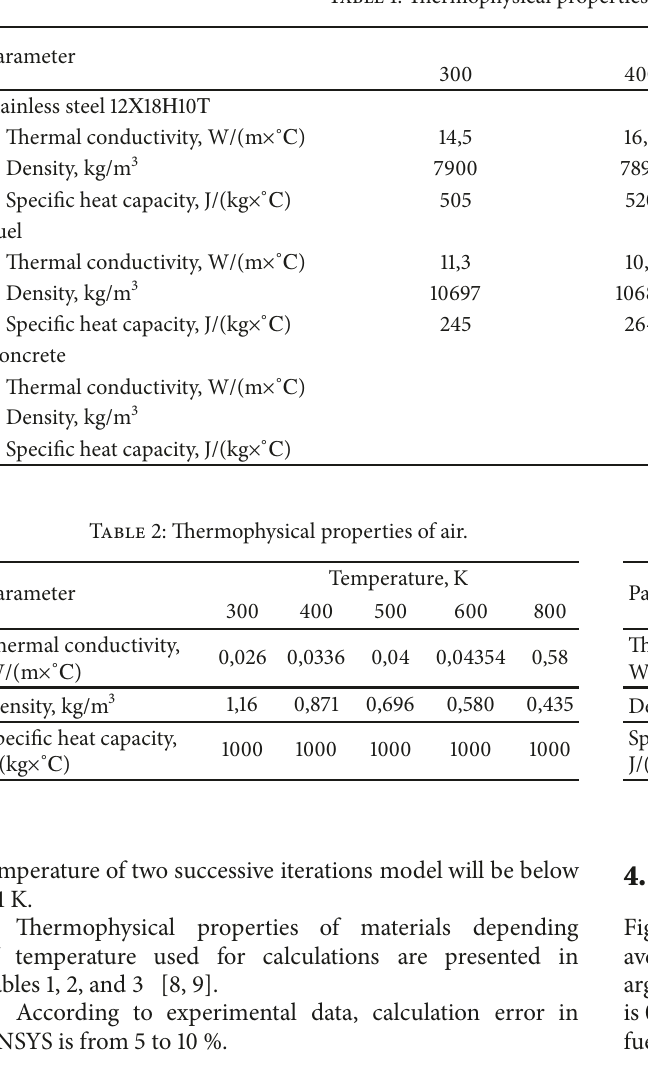
Figure 2: The layout of fuel elements in FA. Table 1: Thermophysical properties of construction material.